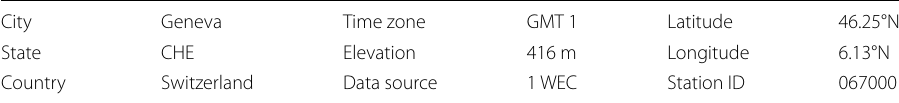
Table 1 Location information for the simulation City